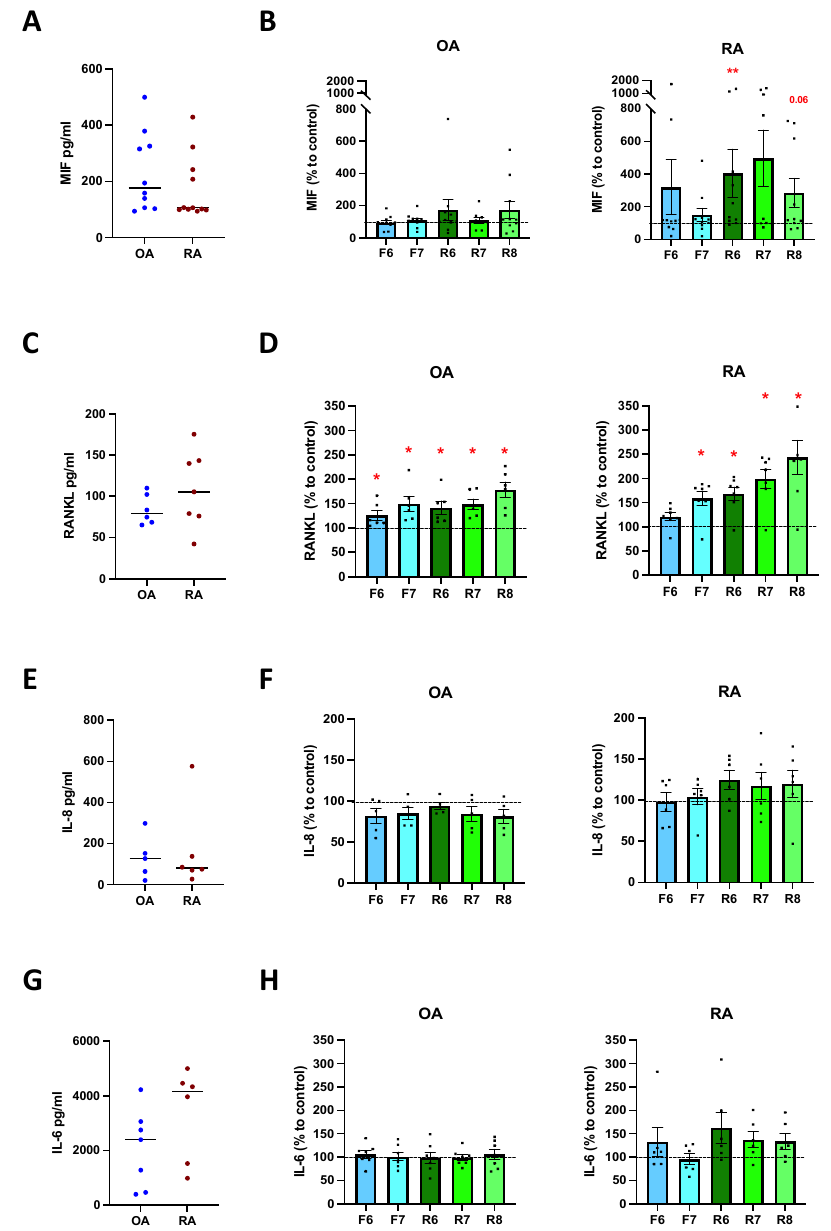
Figure 5. Cytokine release after DR stimulation of primary osteoblasts. Isolated osteoblasts were cultured for 24 h in presence of specific DR agonists, and cytokines were then measured in culture supernatants. ( A ): basal amount of macrophage migration inhibitory factor (MIF) in OA and RA patients. ( B ): quantification of MIF in OA ( left ) and RA ( right ) patients expressed as percentage to control without DR agonist. ( C ): basal amount of receptor activator of nuclear factor- κ B ligand (RANKL) in OA and RA patients. ( D ): quantification of RANKL in OA ( left ) and RA ( right ) patients expressed as percentage to control without DR agonist. ( E ): basal amount of interleukin 8 (IL-8) in OA and RA patients. ( F ): quantification of IL-8 in OA ( left ) and RA ( right ) patients expressed as percentage to control without DR agonist. ( G ): basal amount of interleukin 6 (IL-6) in OA and RA patients. ( H ): quantification of IL-6 in OA ( left ) and RA ( right ) patients expressed as percentage to control without DR agonist. OA n = 4–10, RA n = 3–11. C = control; F = Fenoldopam; R = Ropinirole; 6 = 10 − 6 M; 7 = 10 − 7 M; 8 = 10 − 8 M. Single dots represent mean value of individual patients. Histograms show mean and SEM. Raw data were used for statistical analysis with Wilcoxon matched pairs signed rank test. * = p < 0.05, ** = p < 0.005. p -value near to significance ( p = 0.06) are indicated in the